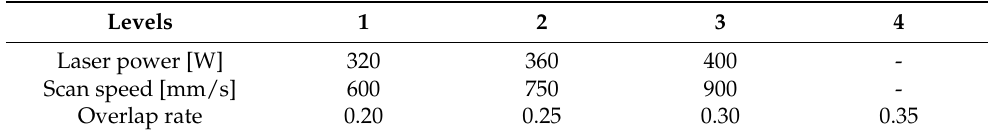
Table 3. Process parameters for the single-layer experiments.